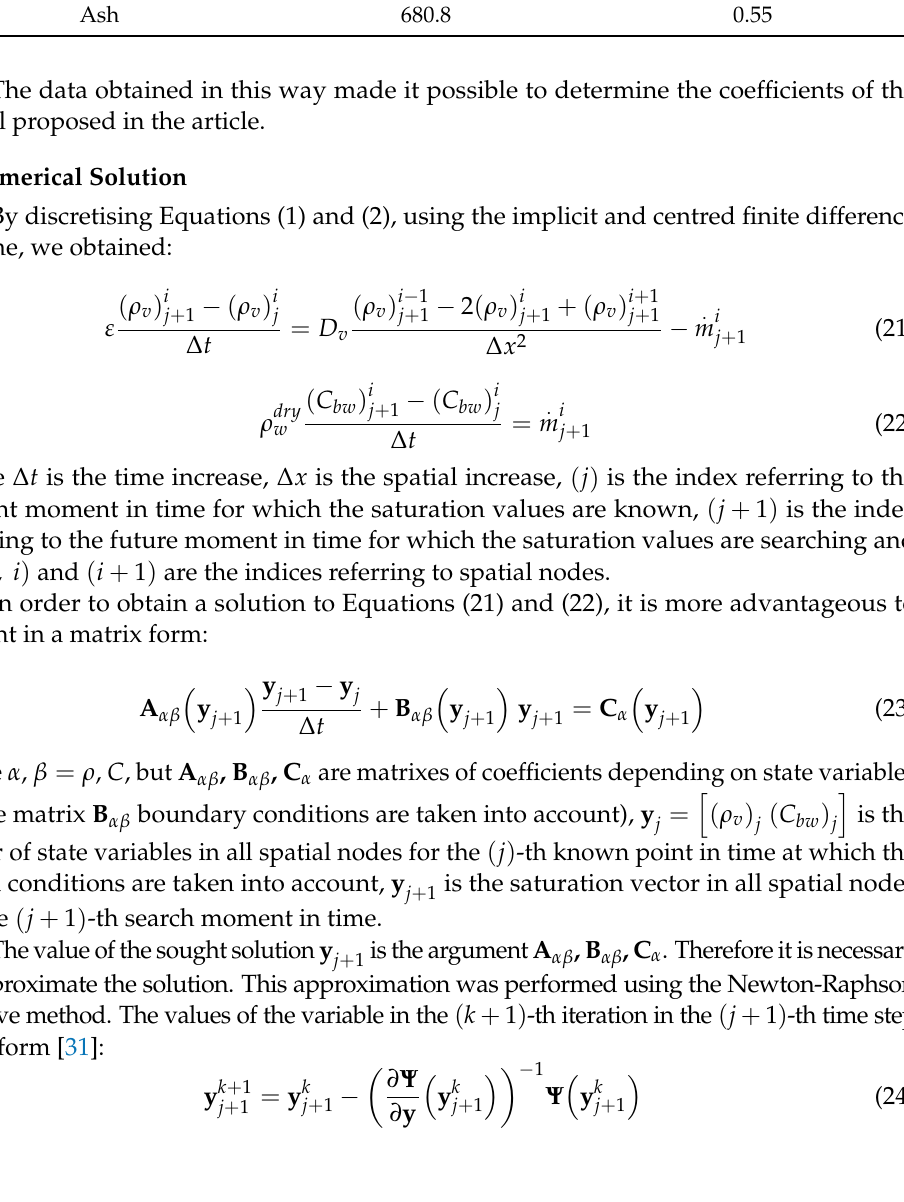
Table 1. Average apparent densities and porosities of the dry wood used in the tests. Average Apparent Density Porosity ε Type of Wood [m 3 /m 3 ] of Dry Wood ρ dry w [kg/m 3 ] Pine 459.6 0.69 Larch 558.4 0.63 Oak 739.8 0.51 Ash 680.8